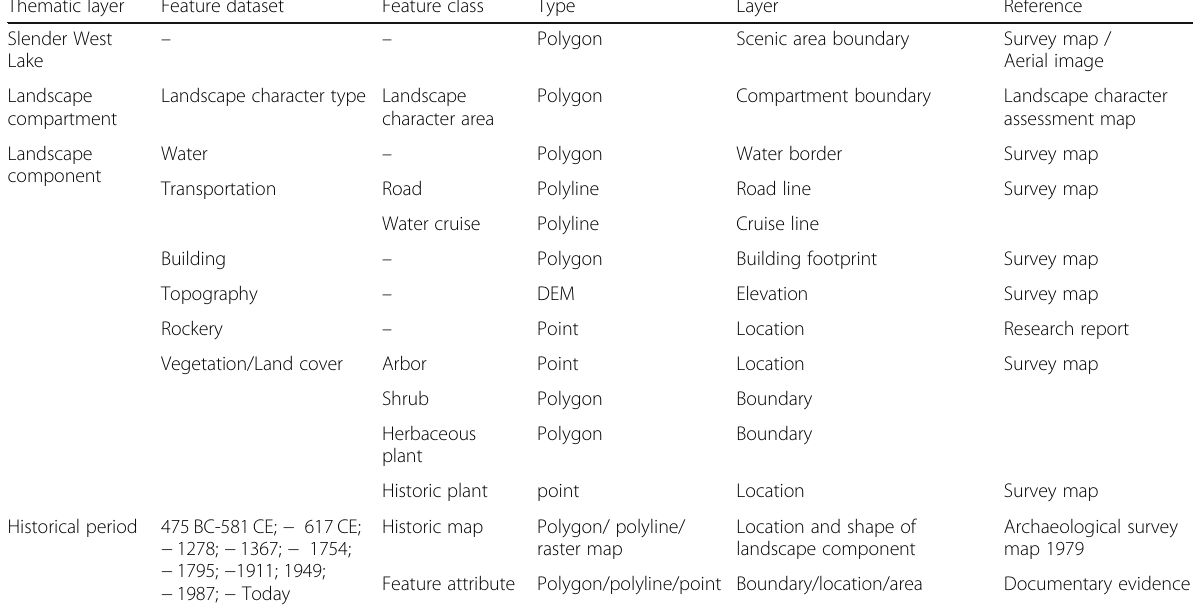
Table 1 The data structure of Slender West Lake geo-database